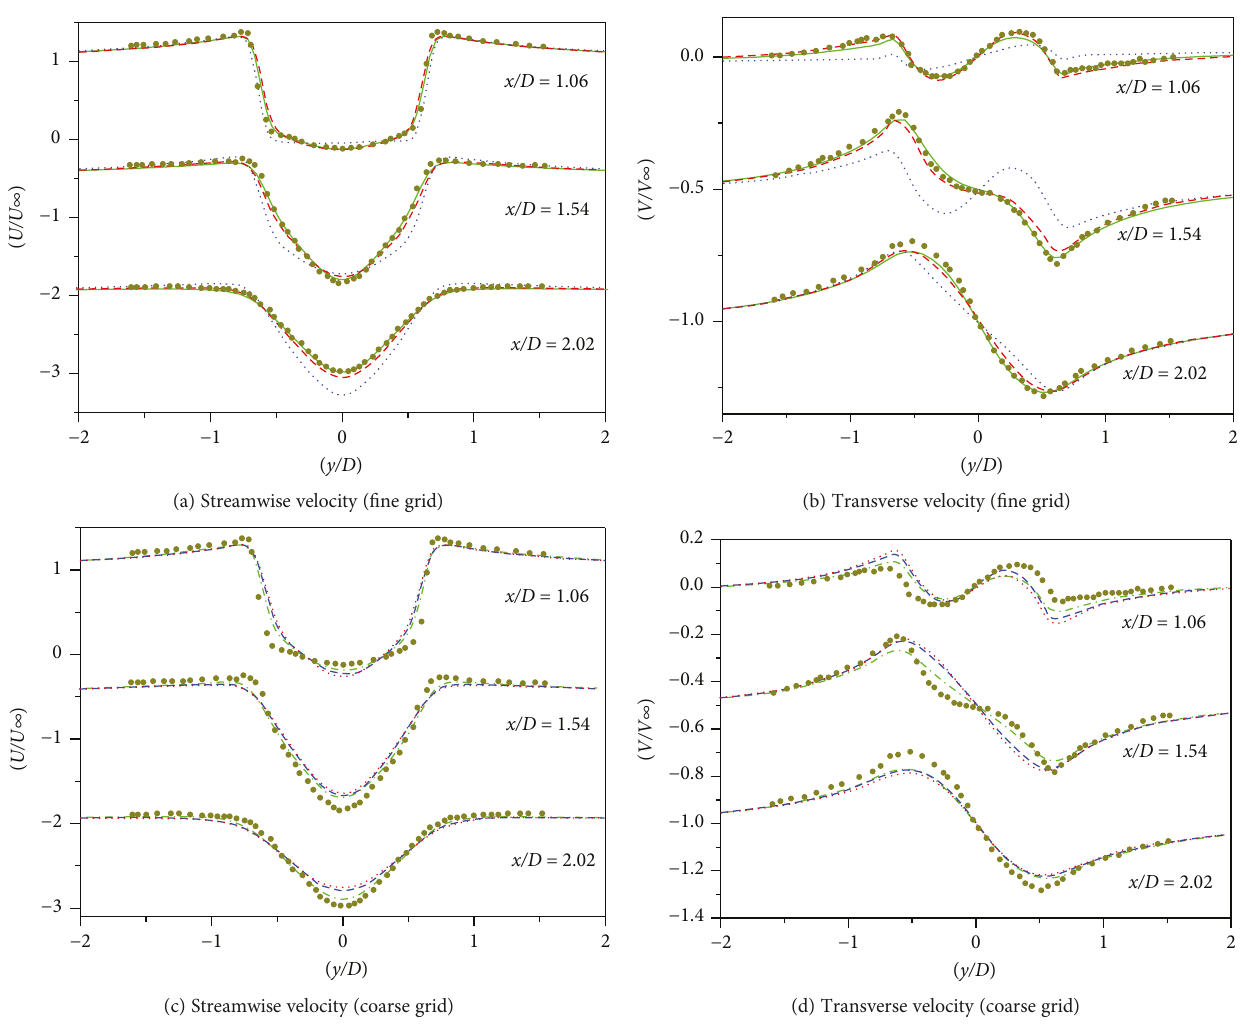
Figure 7: Mean velocity distributions at di ff erent sections (for details, see the caption for Figure